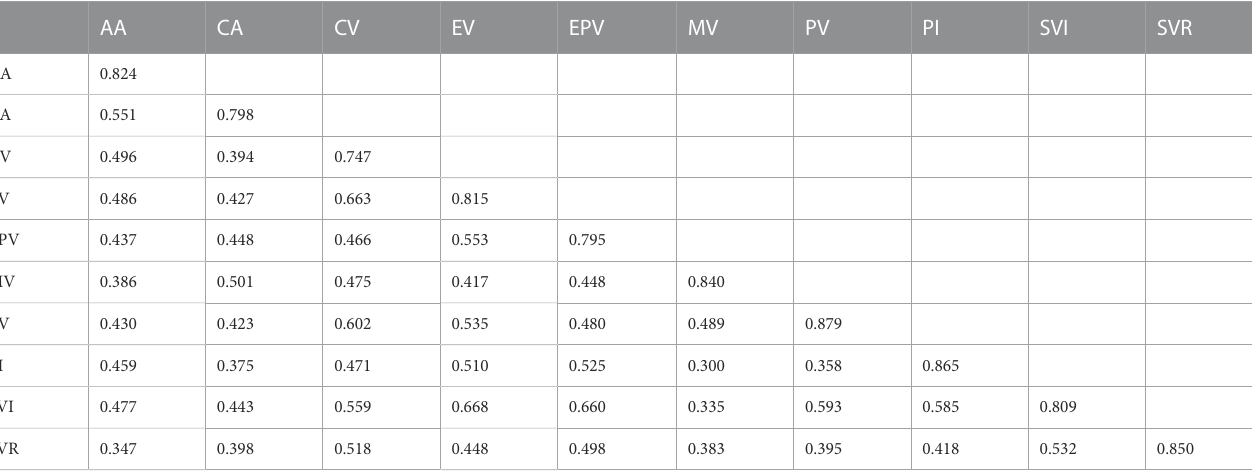
TABLE 3 Discriminant validity Fornell-Larcker